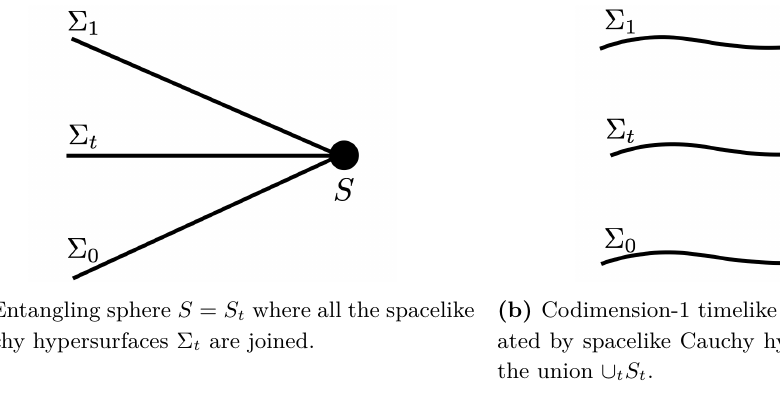
Figure 2. Foliation leaves Σ t with boundaries S t